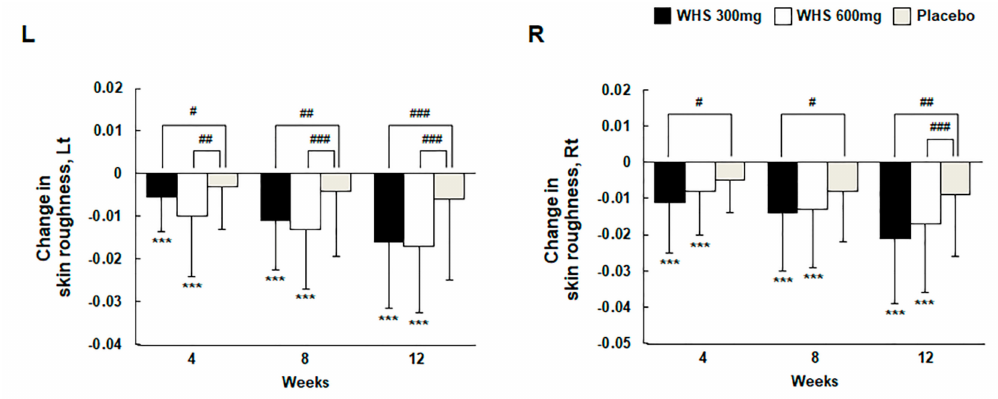
Figure 7. Changes in skin roughness with WHS or placebo after administration for 12 consecutive weeks. Skin roughness was measured with an Antera 3D CS. * indicates compared within groups; p -value (*** p < 0.001) for Wilcoxon signed-rank test. # indicates compared between WHS 300 mg group and placebo group, WHS 600 mg group and placebo group; p -value ( # p < 0.05, ## p < 0.01, and ### p < 0.001) using the Wilcoxon rank-sum